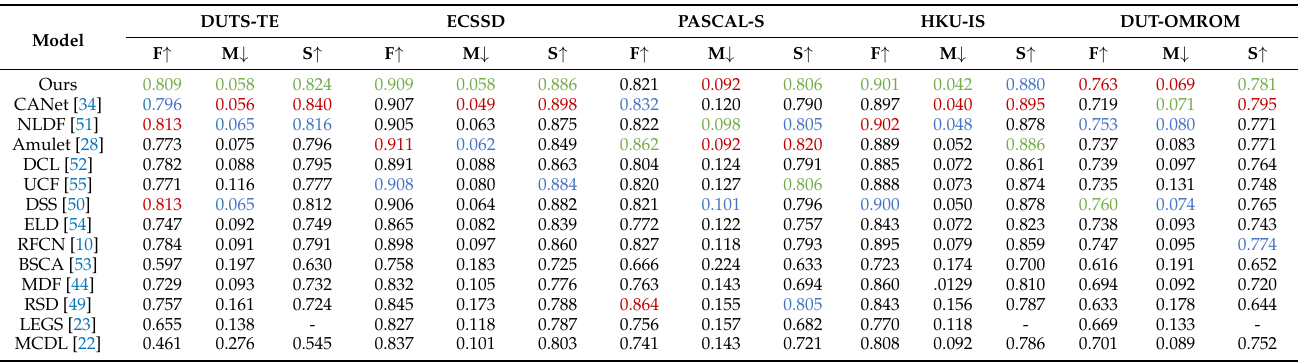
Table 5. Quantitative evaluation. Comparison of different salient detection methods (the best three results are marked as red, green, and blue respectively).